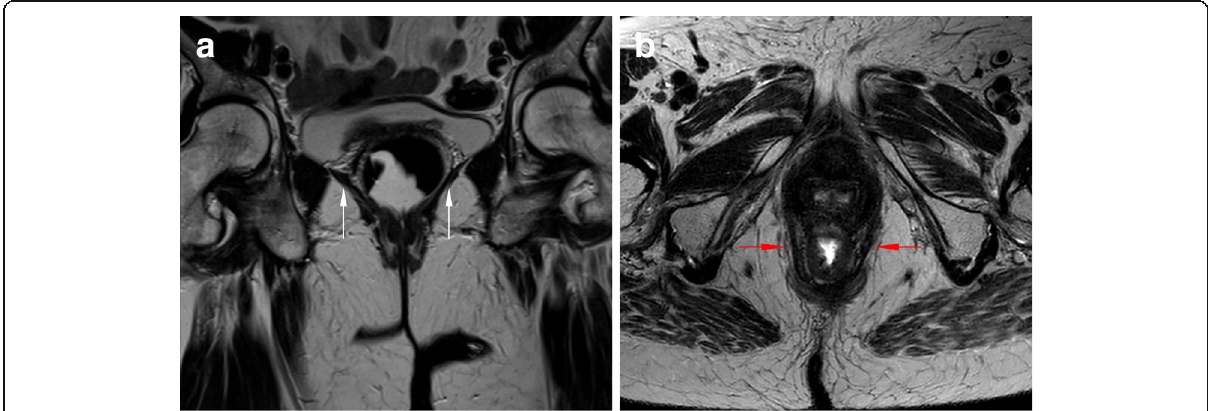
Fig. 4 Pelvic muscles. ( a, b ) Coronal ( a ) and axial ( b ) T2-TSE images of the pelvic diaphragm, showing the iliococcygeus (white arrows) and puborectalis (red arrows)